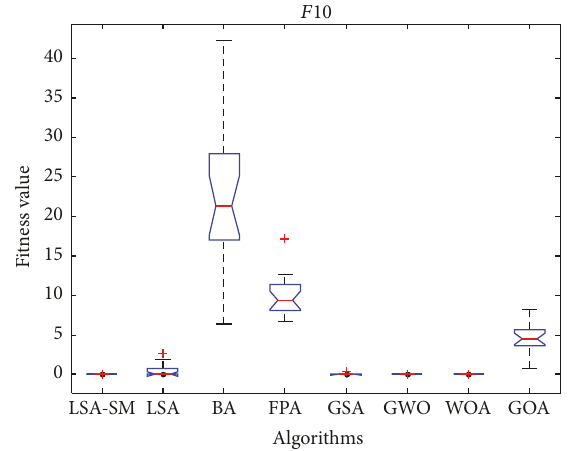
Figure 33: 𝐷 = 4 , ANOVA test of global minimum for 𝑓 11